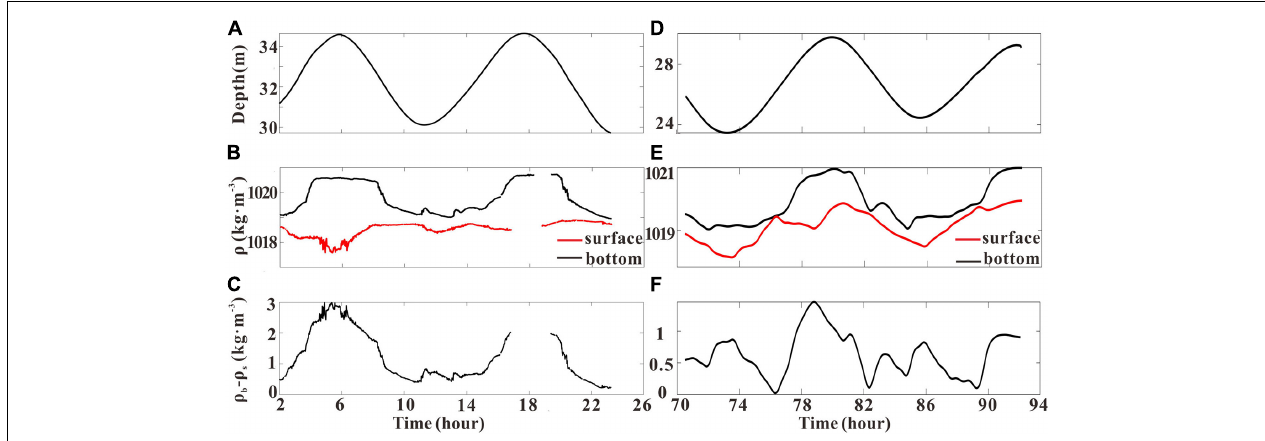
FIGURE 7 | Time series of water depth, surface (red line) and bottom (black line) density, and the surface–bottom density difference at GJ-01 (A–C) , and water depth, surface (red line) and bottom (black line) density, and the surface–bottom density difference at GJ-02 (D–F) .